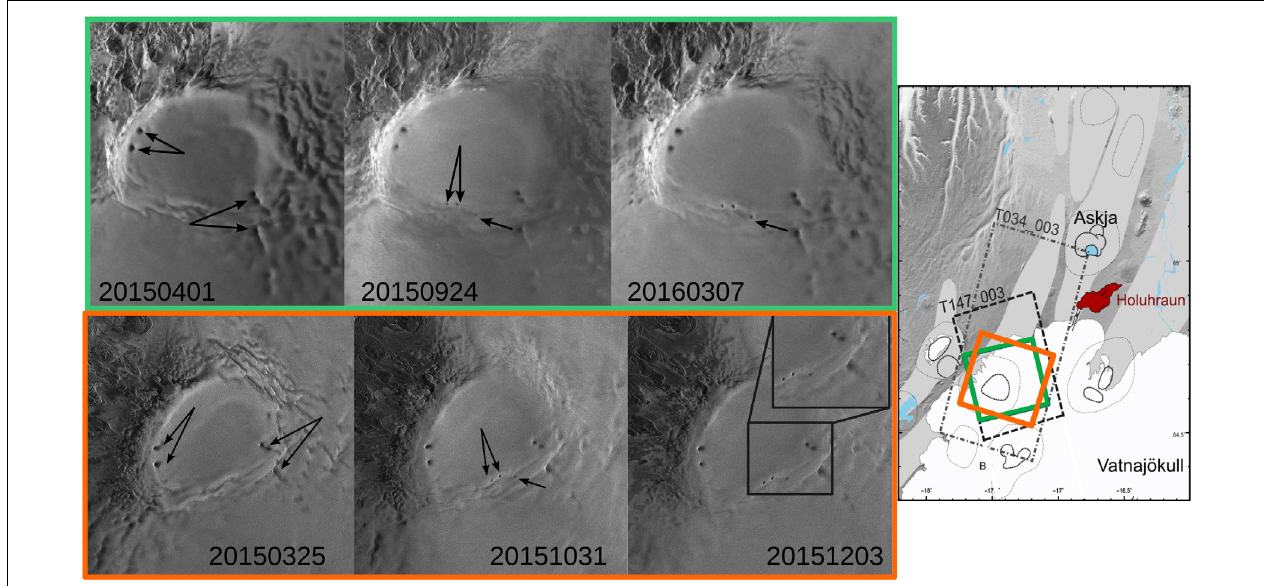
FIGURE 11 | Tracking surface changes at the Bár ð arbunga ice-capped caldera using SAR amplitude images. Ascending (track 147, beam 03, upper panel , green color) and descending (track 34 beam 03, bottom panel , orange color) TSX scenes were used for monitoring the evolution of ice cauldrons located along the ring faults bordering Bár ð arbunga caldera during the 2014–2015 winter and in the year following the end of the Holuhraun eruption. In the first column, arrows indicate all ice cauldron identified, in the next images arrows point out significant surface